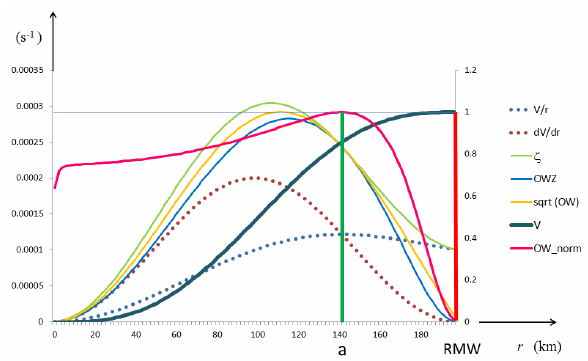
Figure 2. Hypothetical tangential wind (thick blue curve) similar to that shown in Fig. 1 from r = 0 to the RMW at 200 km, with associated vorticity terms: relative vorticity (thin green curve), curvature vorticity (blue dotted curve), shear vorticity (brown dotted curve), the square root of the Okubo-Weiss parameter (thin yellow curve), the normalised Okubo-Weiss (mauve curve), and zero Coriolis OWZ (pale blue curve). The vorticity scale is given by the left vertical axis, and the OW norm scale is given in the right vertical axis. The maximum tangential wind is 20 ms − 1 . The green and red vertical lines are included for ease of comparison with the Favourable and Hostile regions of Fig. 1. The blue horizontal line represents OW norm = 1.